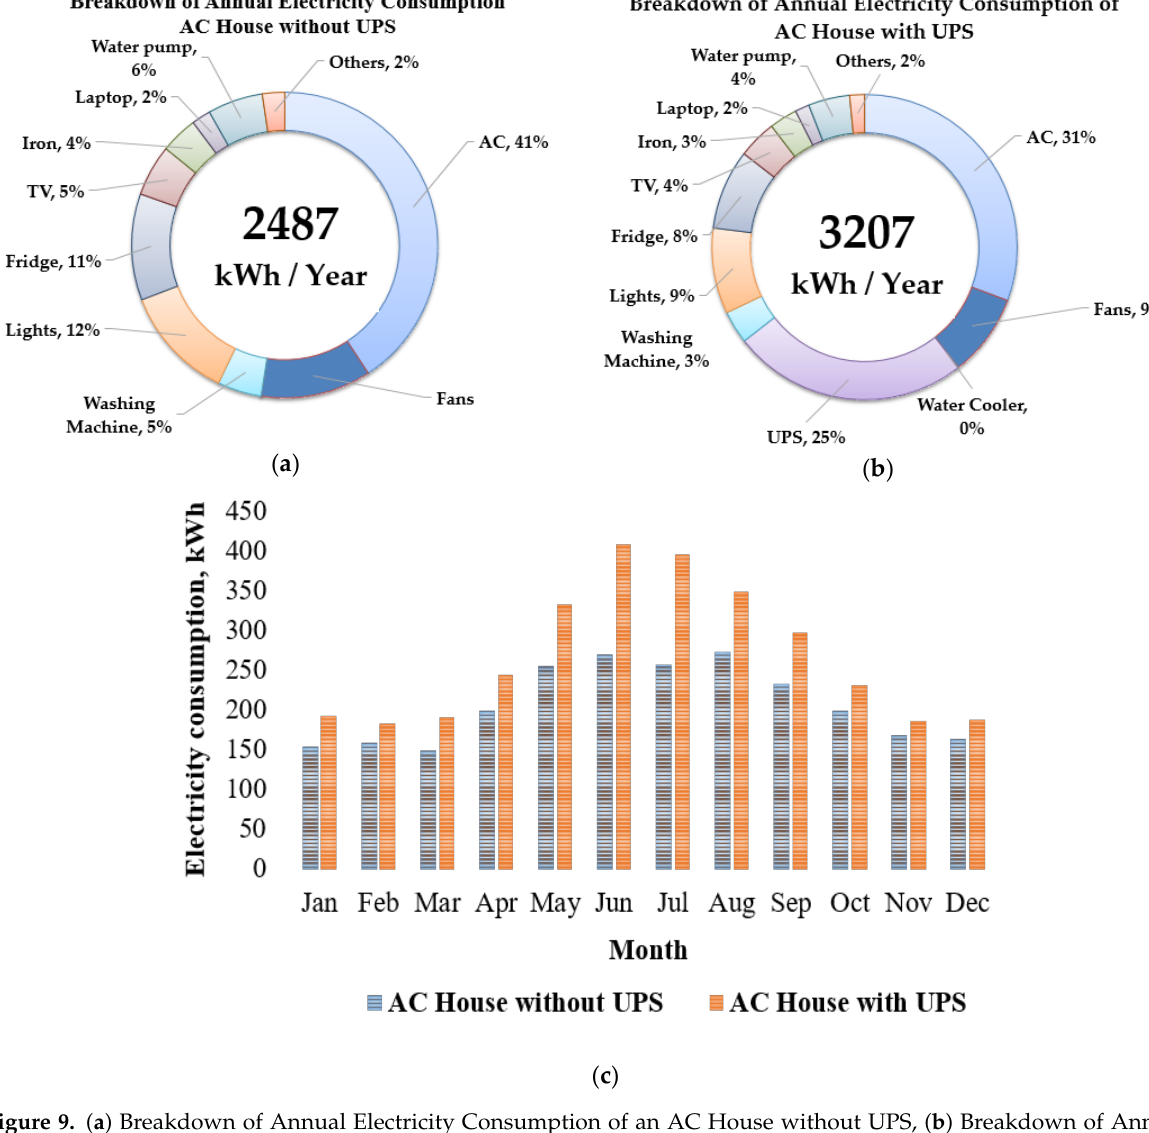
Figure 9. ( a ) Breakdown of Annual Electricity Consumption of an AC House without UPS, ( b ) Breakdown of Annual Electricity Consumption of an AC House with UPS ( c ) Monthly electricity consumption of AC houses with and without UPS.